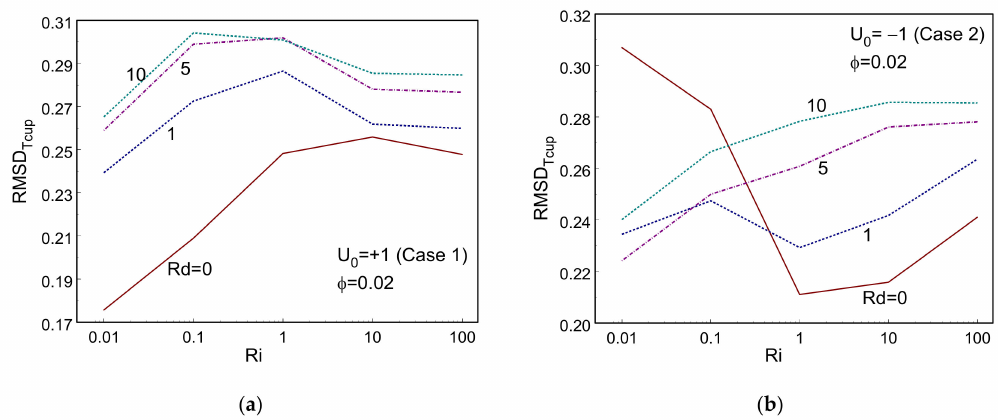
Figure 13. RMSD Tcup for di ff erent Ri and Rd values. ( a ) Case 1; ( b ) Case 2.